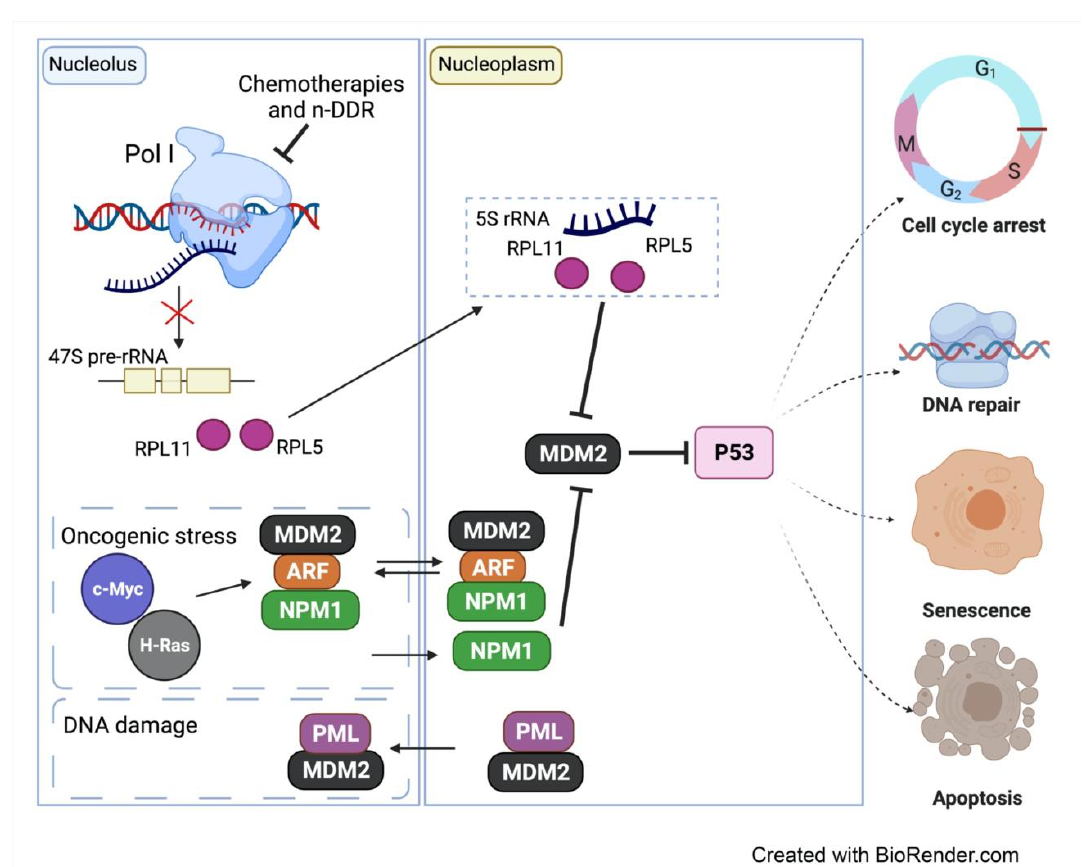
Figure 5. The nucleolar response to different types of stress. Chemotherapies and n-DDR inhibit Pol I transcription and ribosome biogenesis. Free ribosomal proteins, RPL11 and PRL5 then shuttle into nucleoplasm and together with 5S rRNA, they sequester the E3 ligase Mdm2 leading to p53 stabilization. Oncogenic stress also results in the activation of p53 via inhibiting Mdm2. Oncogene such as c-MYC and H-RAS lead to the induction of ARF levels, which together with NPM1 bind and inhibit Mdm2 to activate p53. NPM1 can also interact and inhibit Mdm2 independent of ARF. In response to DNA damage, the PML was also shown to sequester Mdm2 in the nucleolus leading to p53 stabilization. Overall, activation of p53 leads to various responses including cell cycle arrest, DNA repair, senescence, and apoptosis.